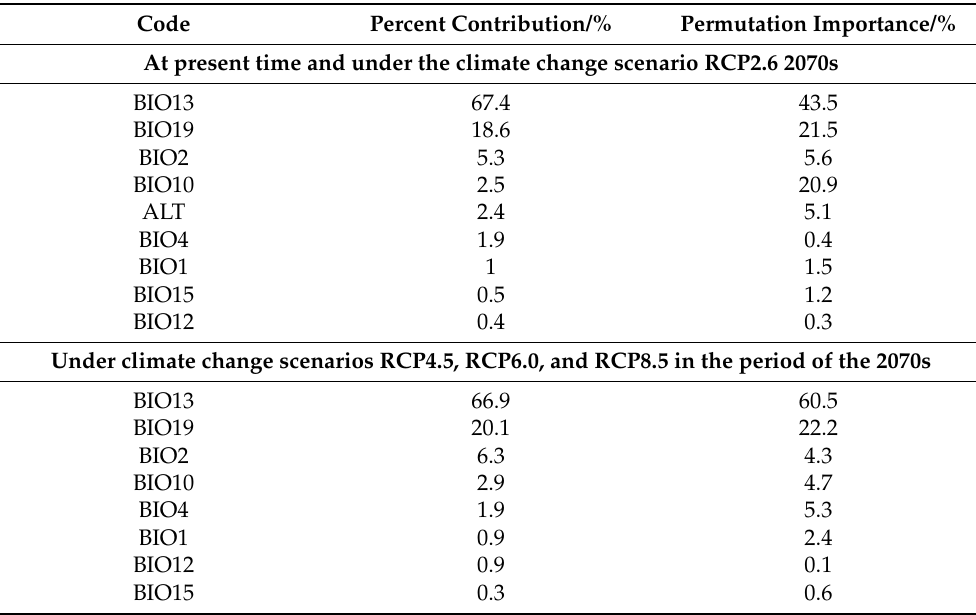
Table 3. Percent contribution and the permutation importance of bioclimatic variables affecting the distribution of Microplitis manilae